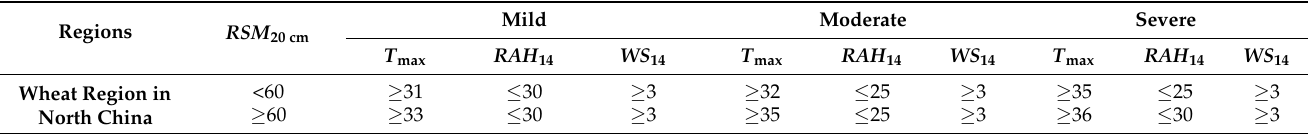
Table 1. The Chinese national meteorological industry standard for determining different levels of dry-hot wind severity. RSM 20cm represents 20cm relative soil moisture (%), which is the percentage of soil water content to the field water holding capacity. T max represents maximum air temperature ( ◦ C), RAH 14 represents relative air humidity (%) at 14:00, WS 14 represents wind speed (m/s) at